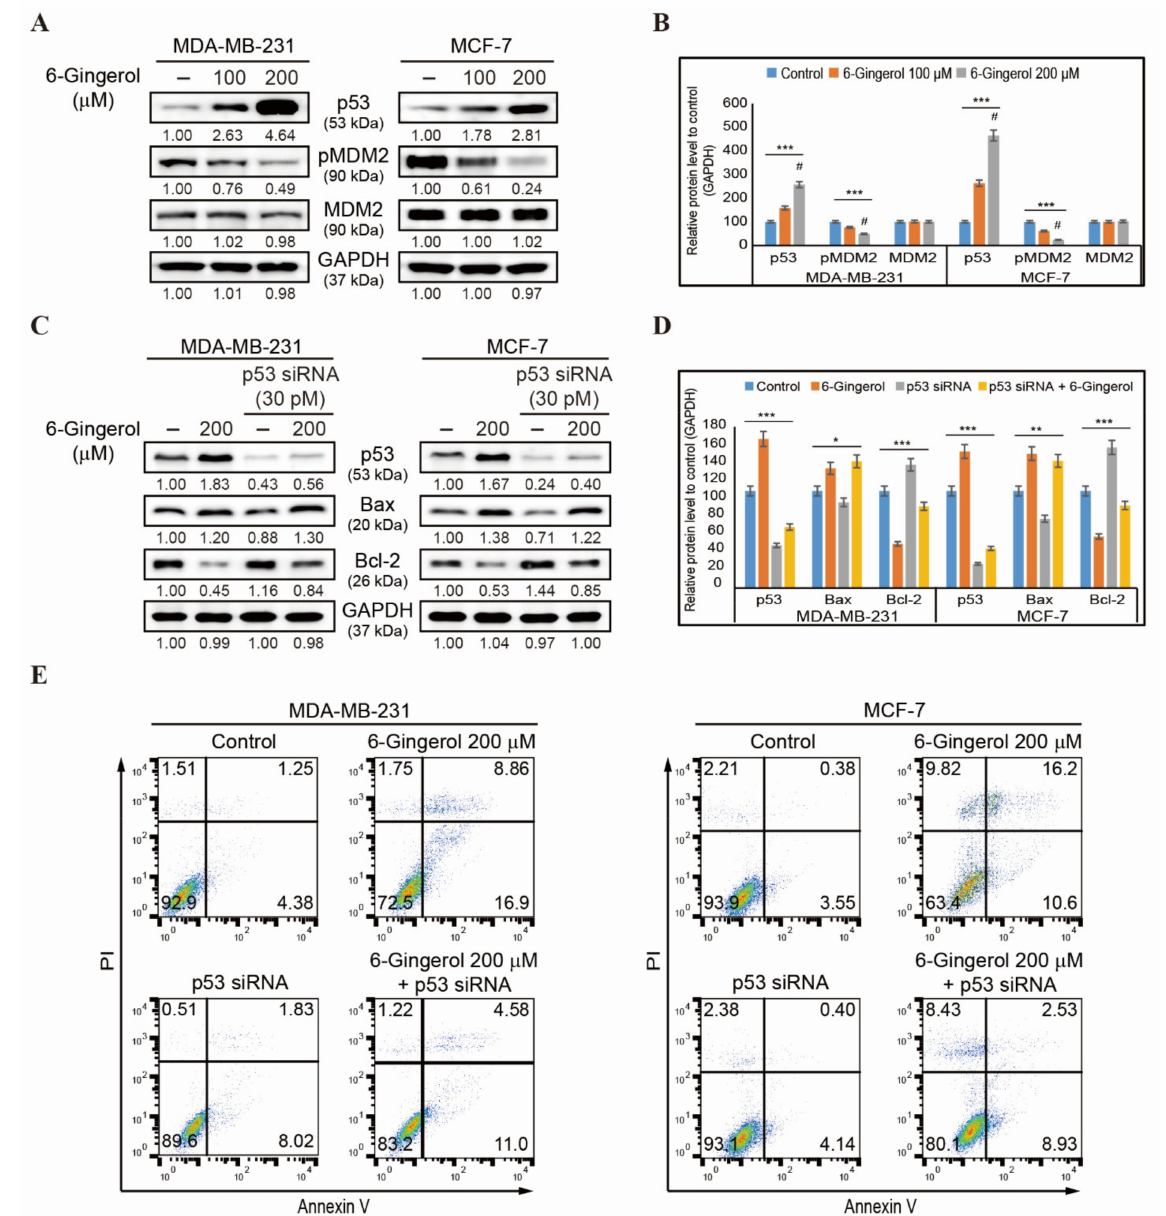
Figure 7. 6-Gingerol induces p53-dependent apoptosis. ( A ) Western blotting of total proteins isolated from MDA-MB-231 and MCF-7 cells after 48 h treatment with 100 and 200 µ M of 6-gingerol showed the expression of p53, pMDM2, and MDM2 proteins. ( B ) Representative expression of proteins was determined by densitometry and normalized to GAPDH. Controls are set to 100. Data were confirmed after repeating the experiment three times. *** p < 0.001 (ANOVA test). # p < 0.001 vs. control. ( C ) Western blotting of total proteins isolated from MDA-MB-231 and MCF-7 cells after 48 h treatment with 200 µ M of 6-gingerol, p53 siRNA, and p53 siRNA + 6-gingerol showing the expression of p53, BAX, and BCL-2 proteins. ( D ) Representative expression of proteins was determined by densitometry and normalized to GAPDH. Controls are set to 100. Data were confirmed after repeating the experiment three times. * p < 0.05, ** p < 0.01, and *** p < 0.001 (ANOVA test). ( E ) Flow cytometry analysis using annexin V and PI staining in MDA-MB-231 and MCF-7 cells after treatment